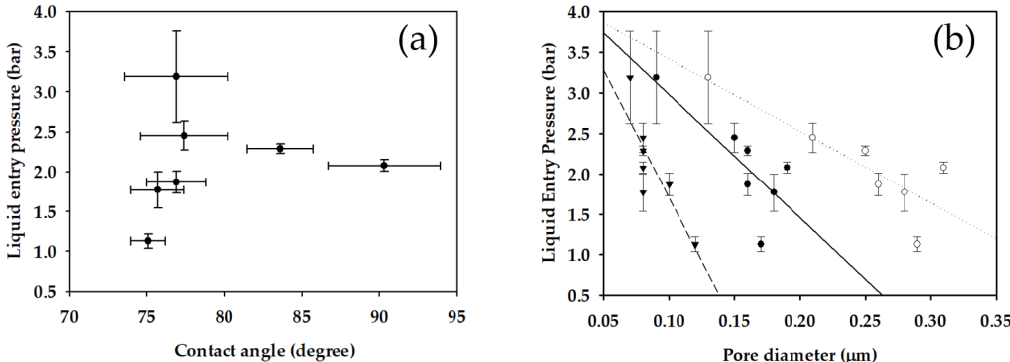
Figure 10. Exploration of factors affecting LEP of fabricated membranes: ( a ) Contact angle; ( b ) pore diameters ( ▼ : minimum pore diameter; ●: mean pore diameter; ○ : maximum pore diameter).